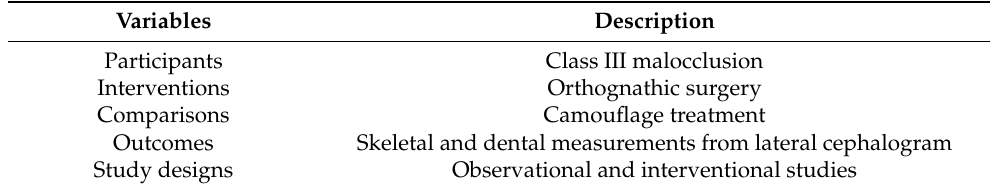
Figure 1. PRISMA guideline for the selection of studies. Table 1. PICOS